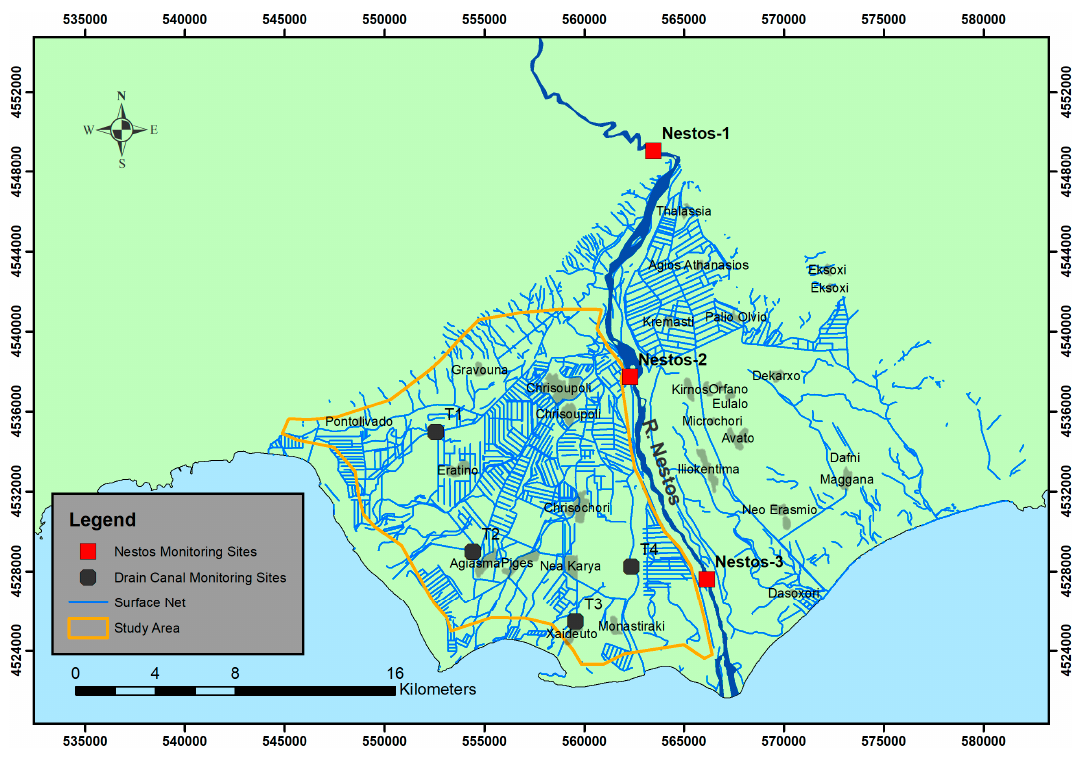
Figure 17. Surface monitoring network points. From the analysis of the Piper and Durov diagrams (Figures 18 and 19), for both the confined and the unconfined aquifers, it is concluded that most of the samples are in the range of magnesium bicarbonate type, and some of the samples show mixed type